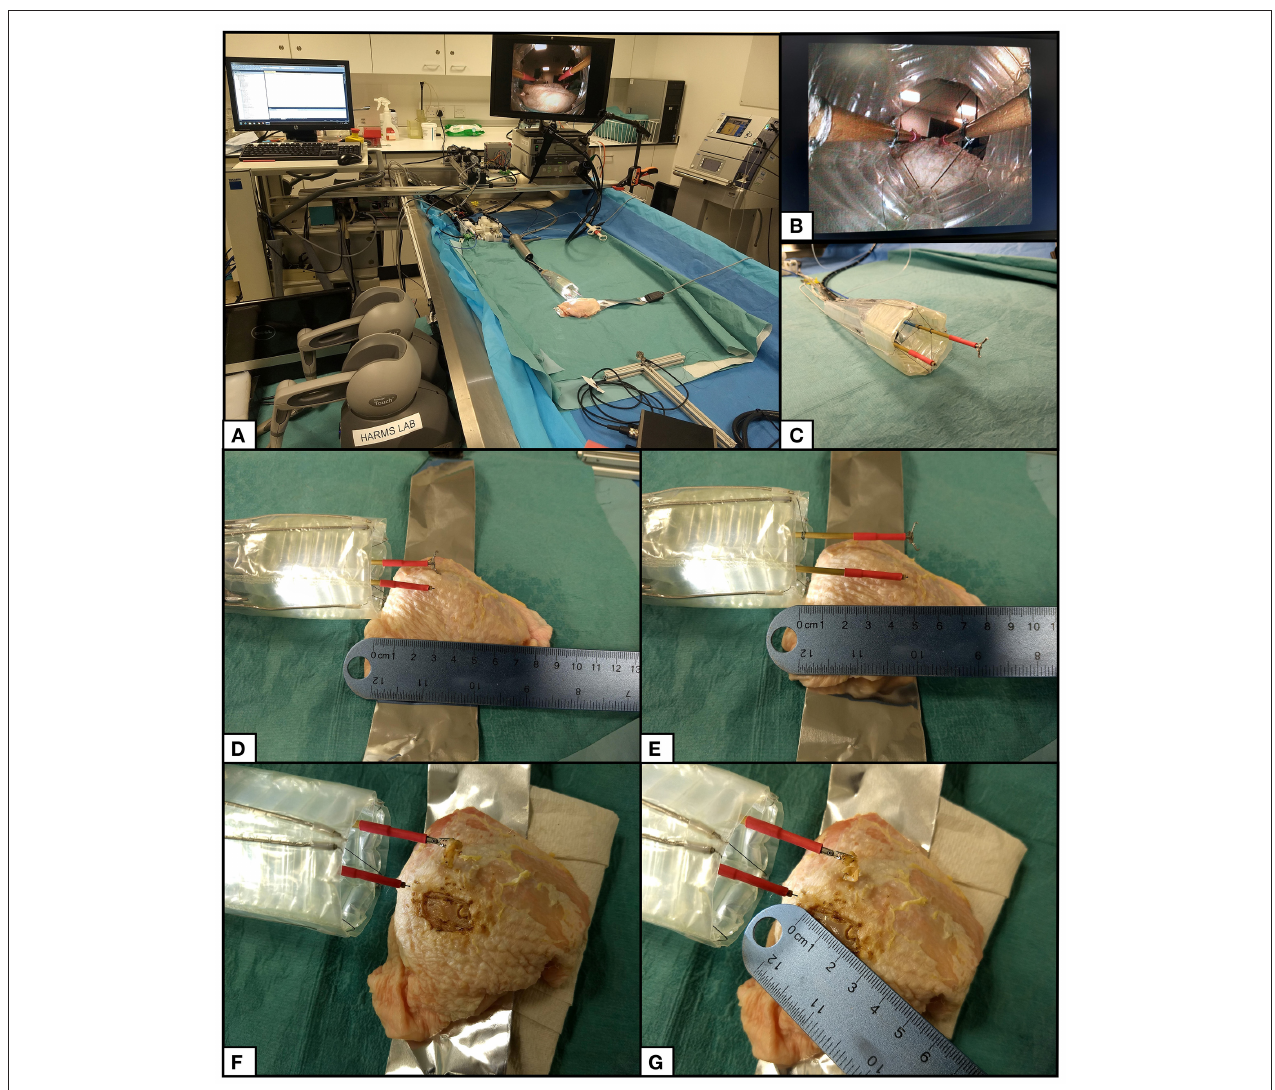
FIGURE 11 | ESD procedure setup and results. (A) Setup of CYCLOPS system with haptic controllers, control computer, motor unit, syringe pump, imaging hub, diathermy unit, and grasper actuator. (B) View of inner structure from retracted flexible endoscope camera. (C) CYCLOPS robot in its calibration position. (D) Both instruments at minimum X position. (E) Both instruments at maximum X position. (F) Chicken breast after removal of skin. (G) Measurement of removed